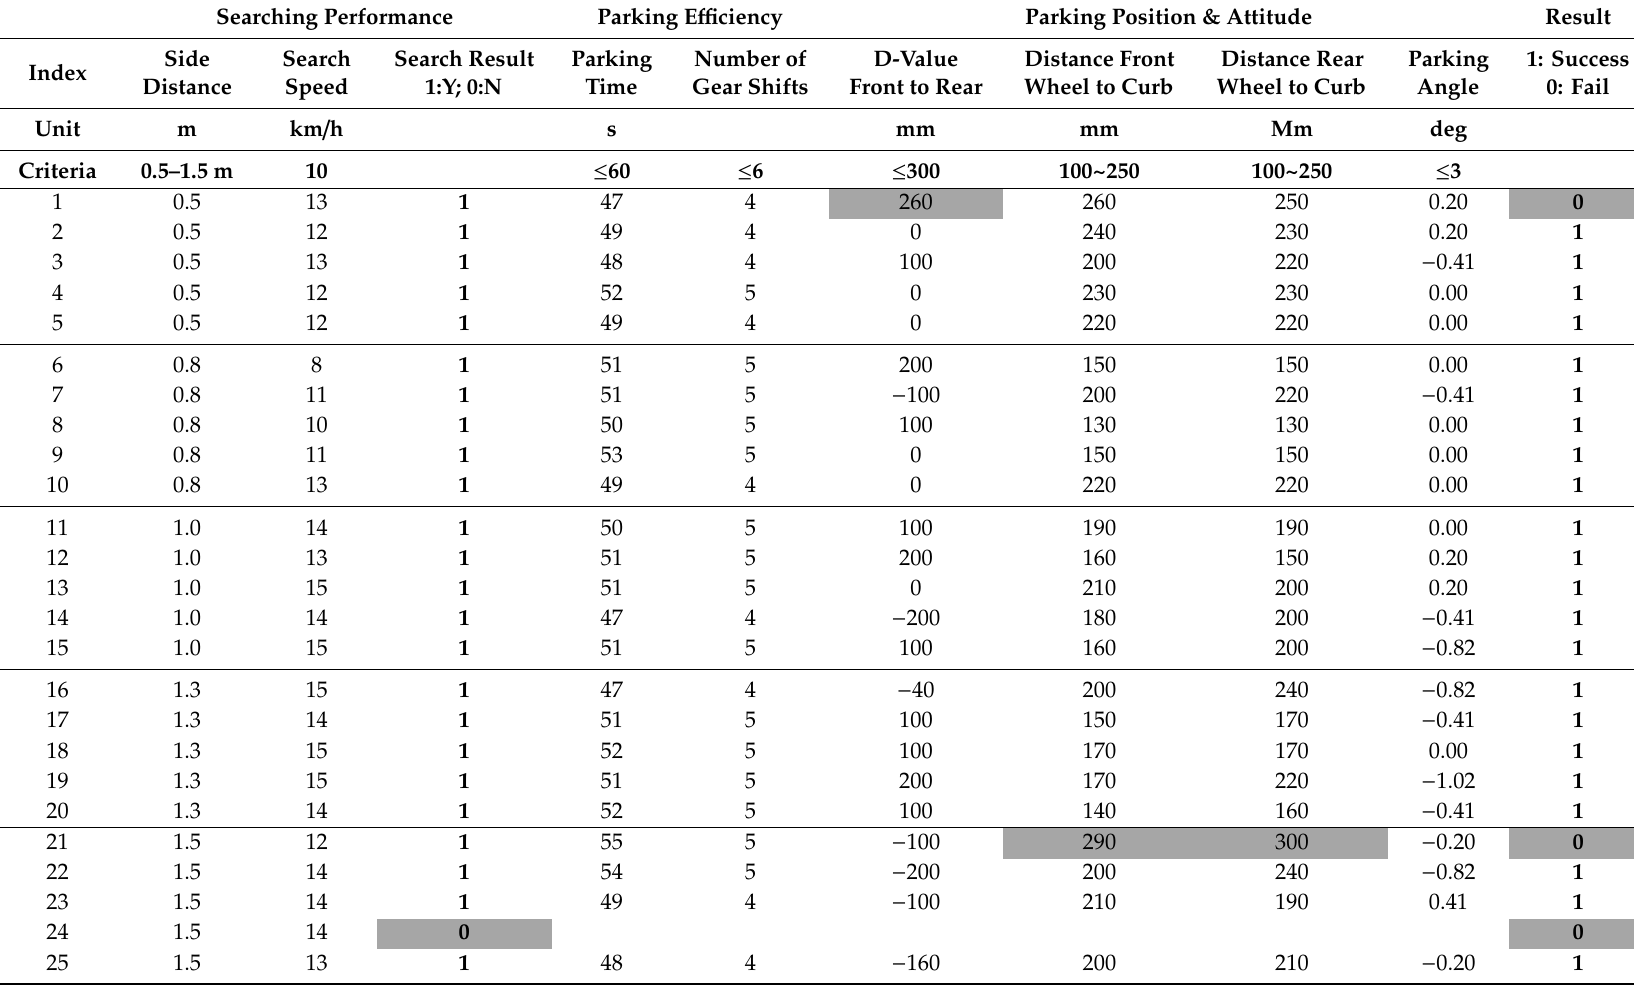
Table 3. Automatic Parking Test Data of Medium Parking